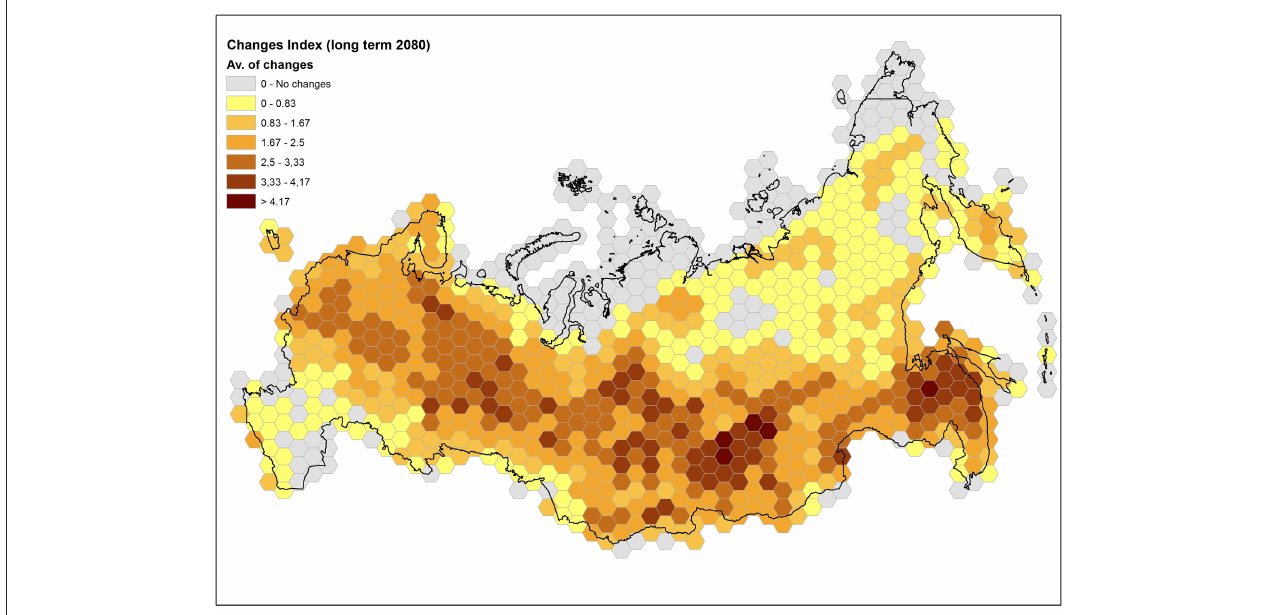
FIGURE 5 | Hex-bin map of the formulated Change Index for the long-term scenario. Each hexagon reports the average value of the number of projected conversions from presence (or not-presence) to not-presence (or presence).